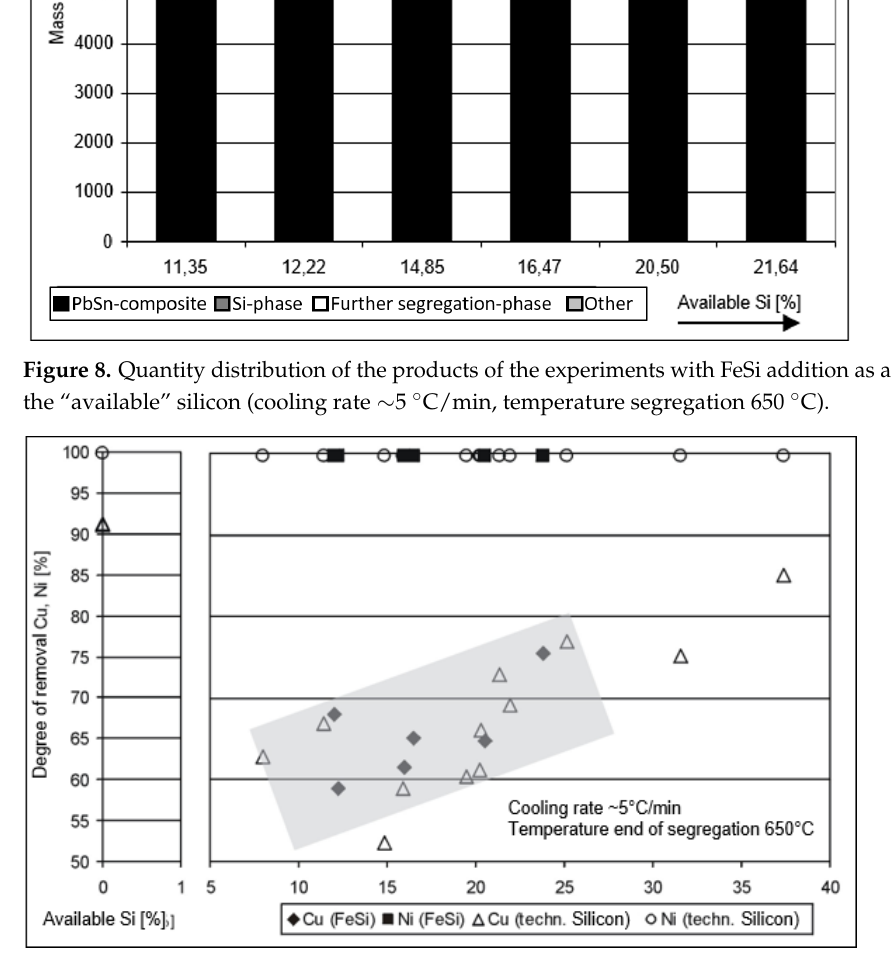
Figure 9. Percentage of copper and nickel separation in relation to the entry as a function of the “available”